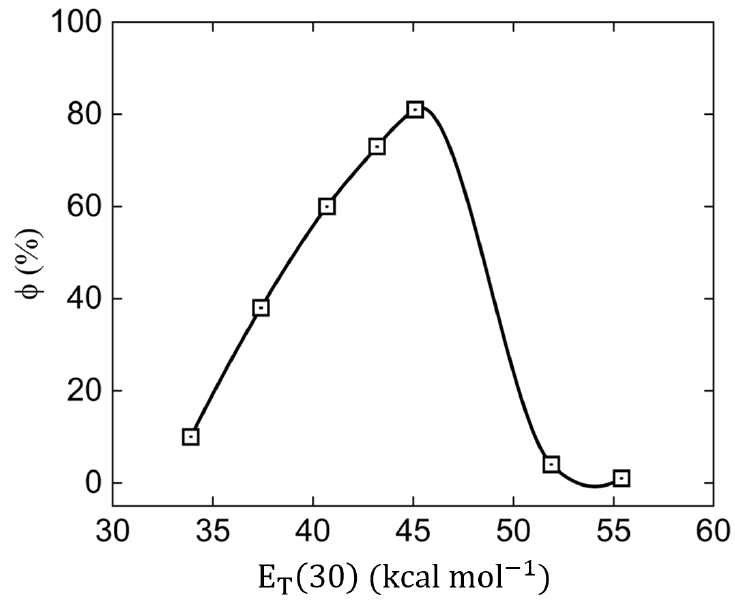
Figure 5. Fluorescence quantum yields of ChN(CH3)2 for different solvents (in ascending order of ET(30): toluene, tetrahydrofuran, dichloromethane, dimethylsulfoxide, dimethylformamide, ethanol, and methanol) determined through the Brouwer method.